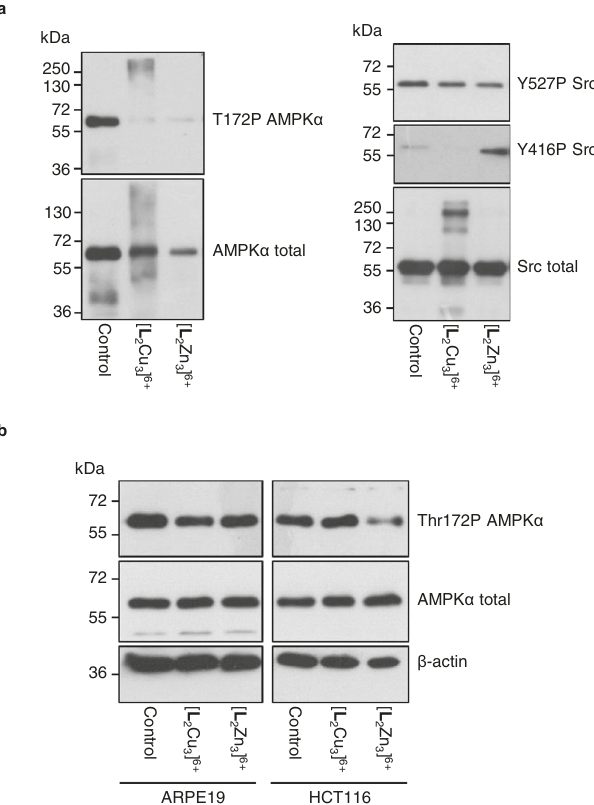
Fig. 8 Western blot analysis of puri fi ed recombinant AMPK and Src [L 2 Zn 3 ] 6 + and [L 2 Cu 3 ] 6 + treatment on cellular phospho-Thr172 AMPK α levels. a Puri fi ed AMPK and Src enzymes were incubated with complexes (50 μ M) for 4 h in the presence of ATP prior to analysis. b ARPE-19 non- cancer cells and HCT116 cancer cells were treated with 10 µ M [L 2 Cu 3 ] 6 + or [L 2 Zn 3 ] 6 + for 4 h prior to harvesting and immunoblot analysis. Similar results were obtained in a minimum of n = 2 independent